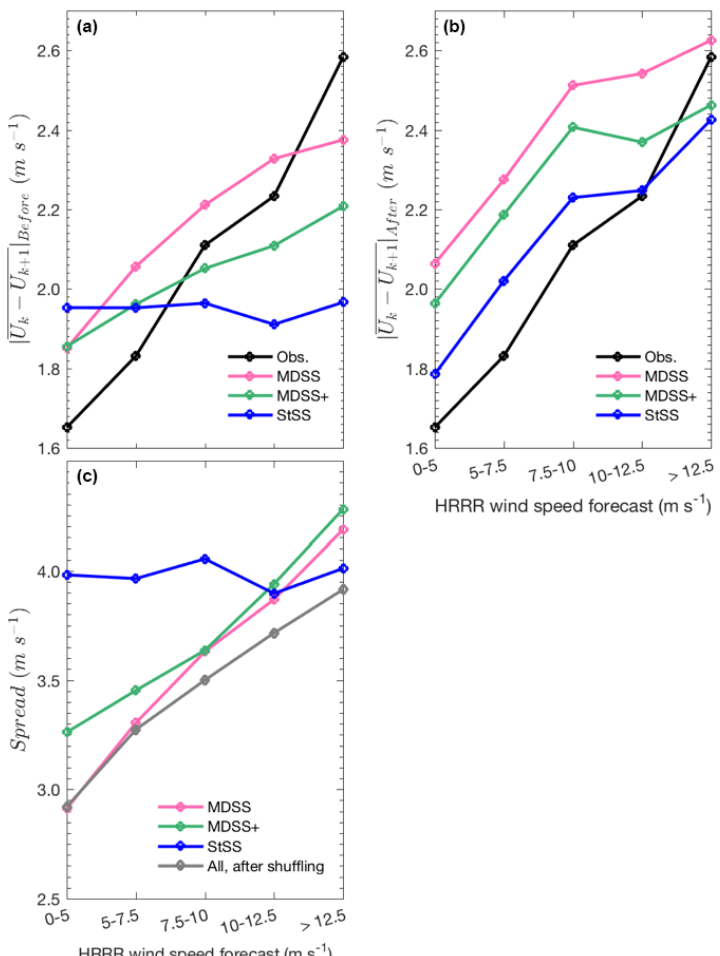
Figure 13. Statistics of observed wind speeds ( U ), unshuffled historical observed wind speed scenarios used by each Schaake shuffle method and the shuffled wind speed forecast scenarios stratified according to the magnitude of the HRRR wind speed forecasts at the respective time. (cid:12) (cid:12) Mean absolute lag 1h wind speed differences ( (cid:12) U k − U k + 1 (cid:12) ) of observations and historical scenarios before (a) and after (b) shuffling and the marginal spread of the unshuffled (pink, blue, and green lines) and shuffled (gray) historical scenarios (c) are shown. The spread is quantified as the mean absolute difference between